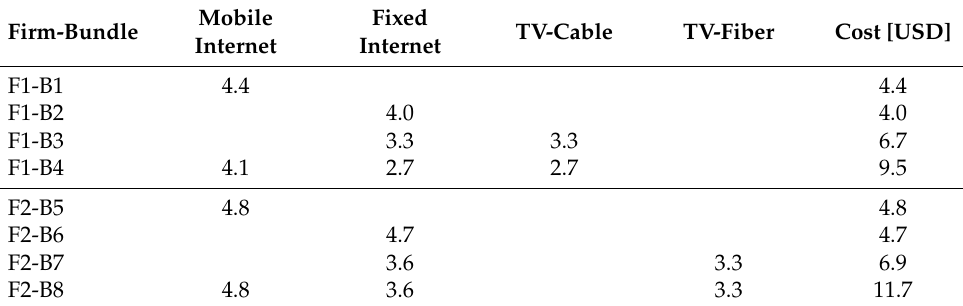
Table 9. Firms’ assortment and bundles costs in